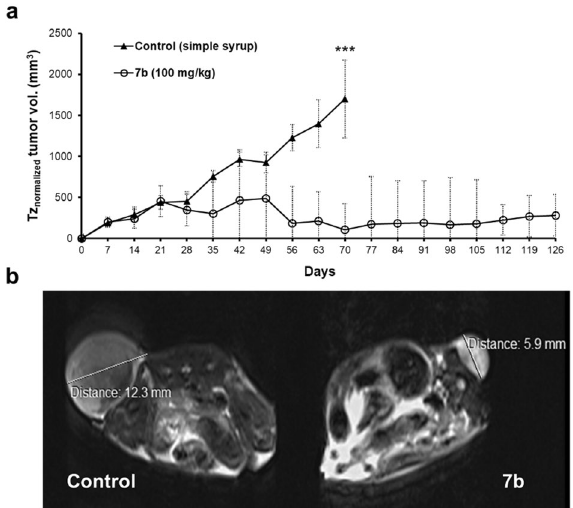
Figure 6. 7b reduces tumor growth and increases the overall survival of nude mice. ( a ) Mahlavu xenografted nude mice were treated with either ( 100 mg/kg) compound 7b suspended in simple syrup or only simple syrup twice a week once the tumor size reached a volume of 150 mm 3 . Tumor sizes are recorded twice a week throughout the experiment. Time-zero normalized data are shown as mean ± SD for each group of animals ( n = 5); *** P < 0.001, as calculated using one-way ANOVA ( b ) Representative MRI images taken at the 135 th day for compound 7b treated group and 105 th day for